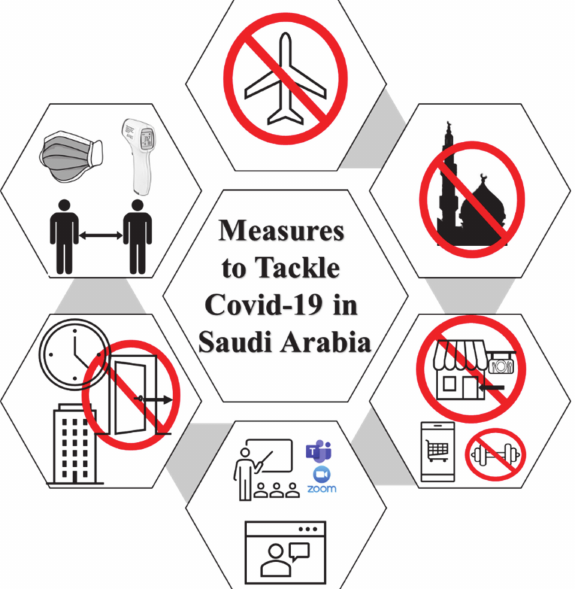
Figure 1. The measures taken to tackle Covid-19 in Saudi Arabia. The diagram summarizes the measures taken by the Saudi government to limit the spread of Covid-19. These measures include: travel bans, suspending religious activities, closure of non-essential shops, changes to workplace (including the switch to distance learning), and imposing curfews. Eventually, new regulations have been in place for a gradual safe return to the lifestyle prior to Covid-19. These guidelines include the mandatory facemask in public, measuring people’s temperature upon entering closed spaces, and other social-distancing